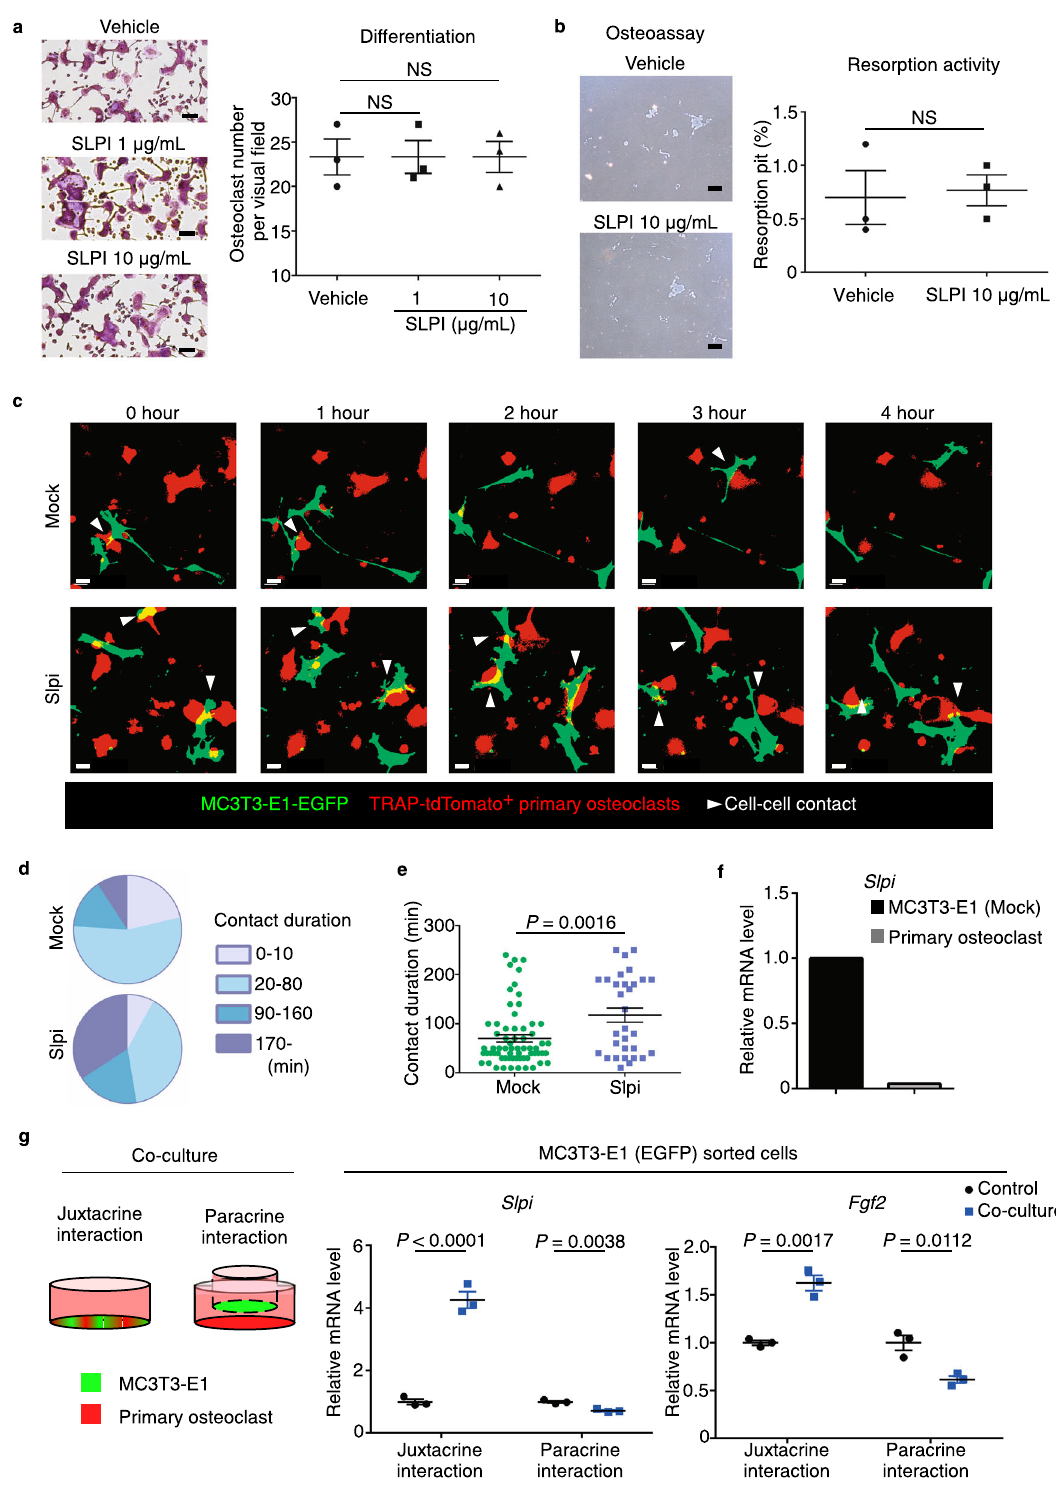
ECFP + osteoblasts and tdTomato + osteoclasts were increased after 3 weeks of PTH treatment (Fig. 4a – c). The densities of ECFP + osteoblasts and tdTomato + osteoclasts between Slpi -KO and WT mice were similar after PTH treatment (Fig. 4a – c). However, the degrees of osteoblast and osteoclast gathering both increased, and their inter- mingling was disrupted by knockout of Slpi . Quanti fi cation of the cell mixture index (CMI), a cell mixture parameter